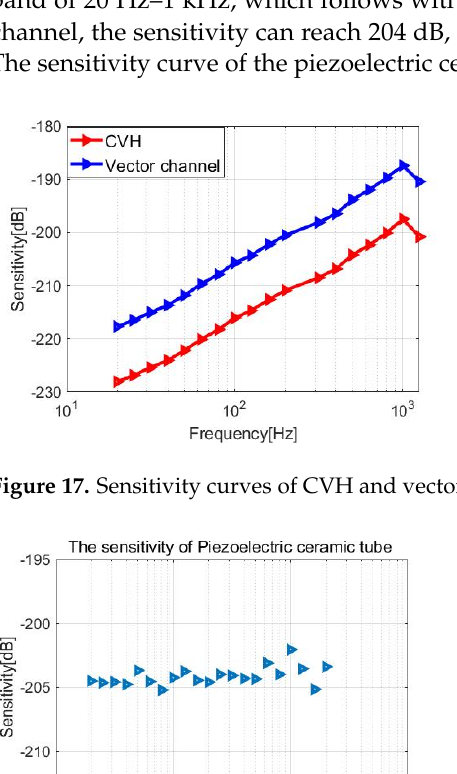
Figure 18. Sensitivity of scalar channel (the piezoelectric ceramic tube).